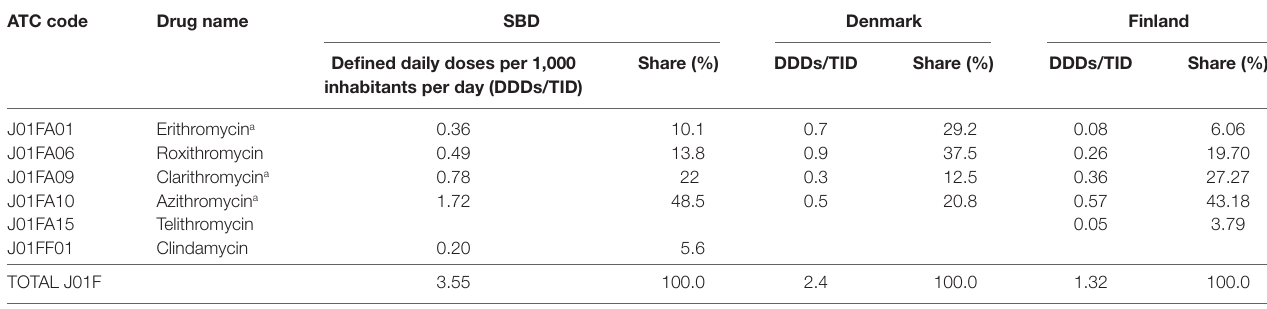
TaBle 5 | Utilization of antibiotics within macrolides and lincosamides subgroup (J01F) in South Backa District (SBD), Denmark and Finland in 2008. aTc code